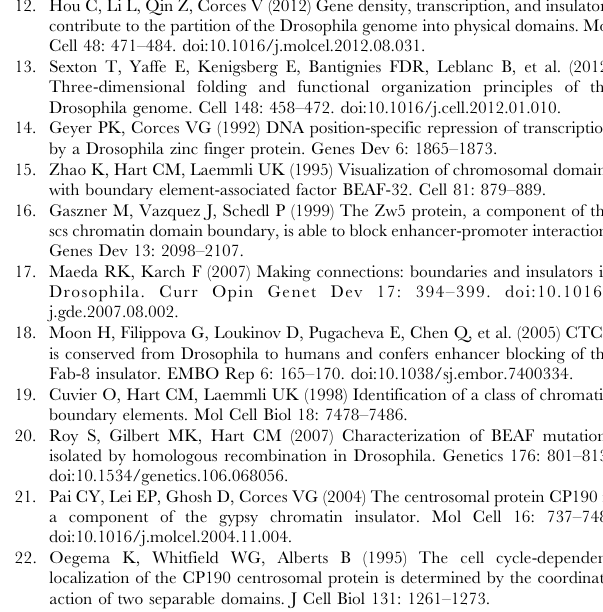
Figure S6 CP190 binding isotherms for DNA NS (open dia- monds) and a DNA fragment of the same length but with the consensous sequence of CP190 [25] (T GACAC TG, open squares). Solid lines represent guides to the eye. Figure S7 Normalized auto-correlation of DNA S -Cy3B (black), B32S (red), DNA S -Cy3B and CP190-BTB/POZ (light green), and a mix of B32S with CP190-BTB/POZ (dark green). The diffusion time of B32S is unchanged by the addition of CP190-BTB/POZ, suggesting that these domains do not interact directly.